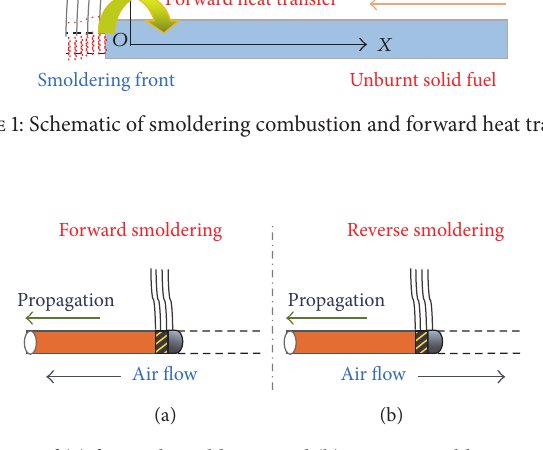
Figure 2: Schematics of (a) forward smoldering and (b) reverse smoldering over thin solid